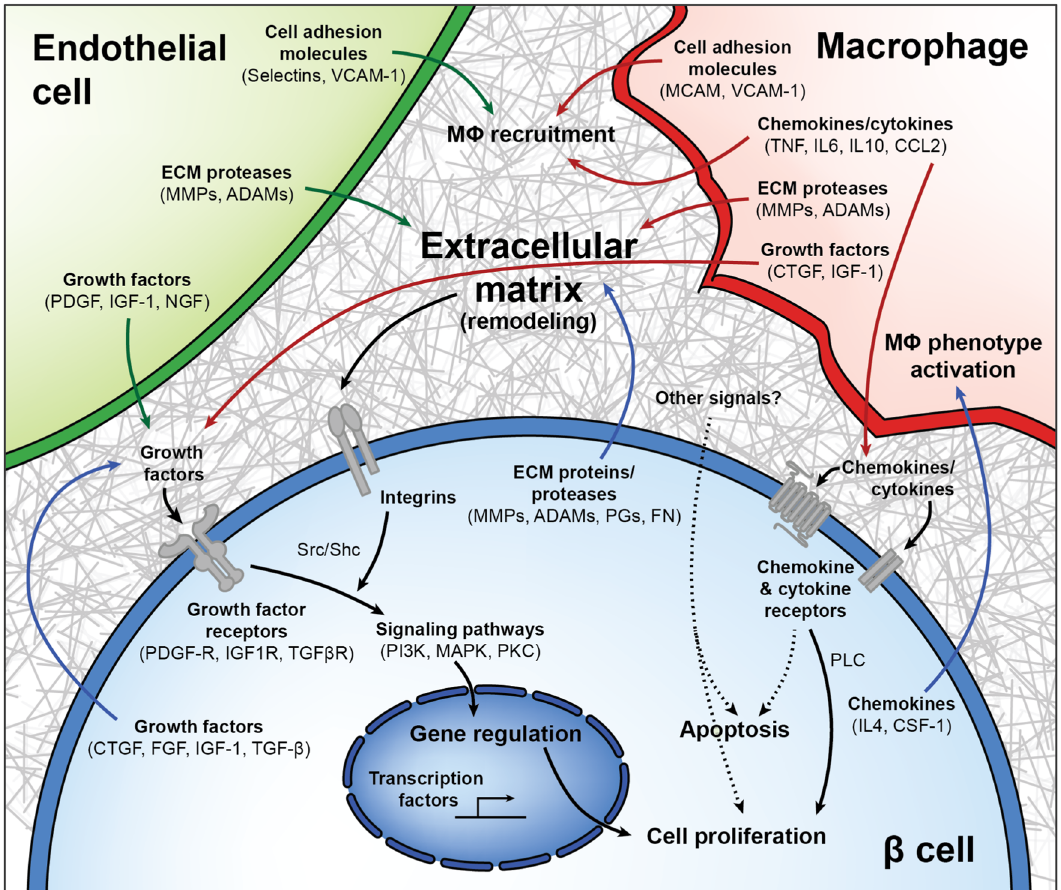
Fig. 6 Model of interactions between β cells, macrophages, endothelial cells, and the extracellular matrix in β cell regeneration. Upon VEGF-A induction, intra-islet endothelial cells (ECs) proliferate while increasing expression of cell adhesion molecules and growth factors and altering their expression of integrins and extracellular matrix (ECM) remodeling enzymes. These adhesion molecules help recruit macrophages (M Φ s), which upon islet in fi ltration also upregulate expression of cell adhesion molecules and pro- and anti-in fl ammatory chemokines and cytokines, in fl uencing further M Φ recruitment in addition to signaling through chemokine and cytokine receptors on β cells. Chemokine and cytokines become increasingly less in fl ammatory as VEGF-A normalizes, as M Φ s produce growth factors and matrix remodeling enzymes that may promote β cell proliferation. Upon VEGF-A induction, β cells exhibit enrichment for several integrin pathways and other proteins involved in ECM remodeling and cell – matrix interactions in addition to regulating expression of chemokines known to support a regenerative (M2 or alternative) M Φ phenotype. Growth factors from all cell types act on an increased number of growth factor receptors being expressed on β cells, activating downstream signals converging on the PI3K/Akt and MAPK pathways. Other signals from cells in the microenvironment, or from the rapidly remodeling ECM, may also play a role in β cell